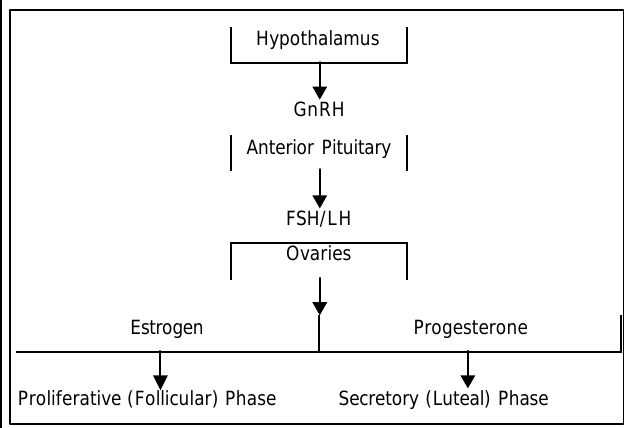
Fig.1 : Pathway of action of hormones for normal menstrual function.